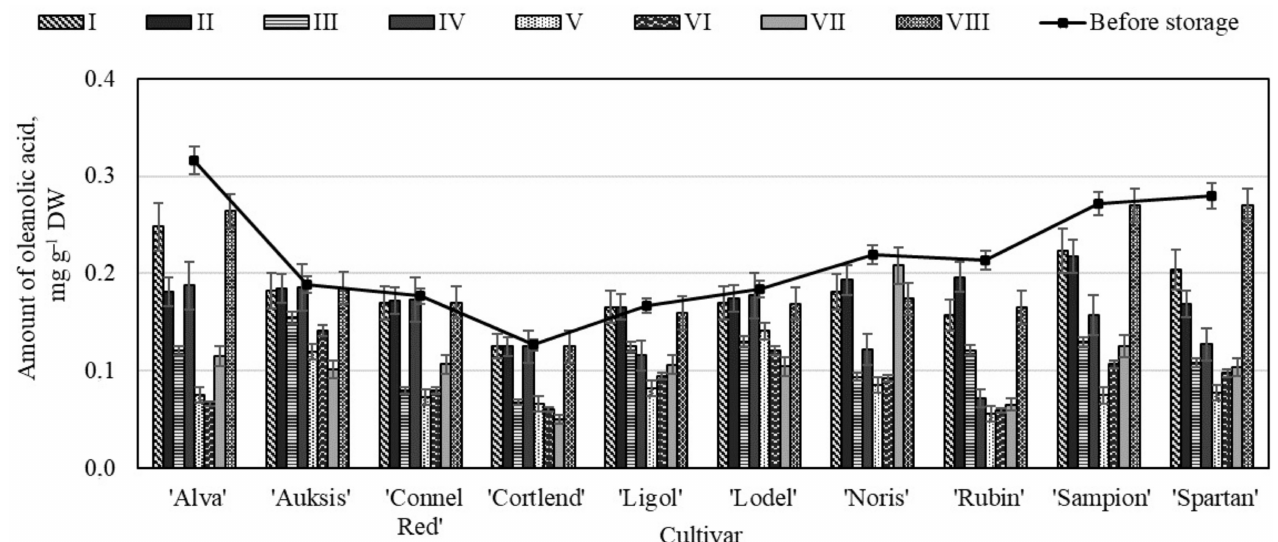
Figure 4. Changes in the amount of oleanolic acid in the whole apple samples before and after storage in CA. The content of oleanolic acid varied the least in the whole apple samples stored